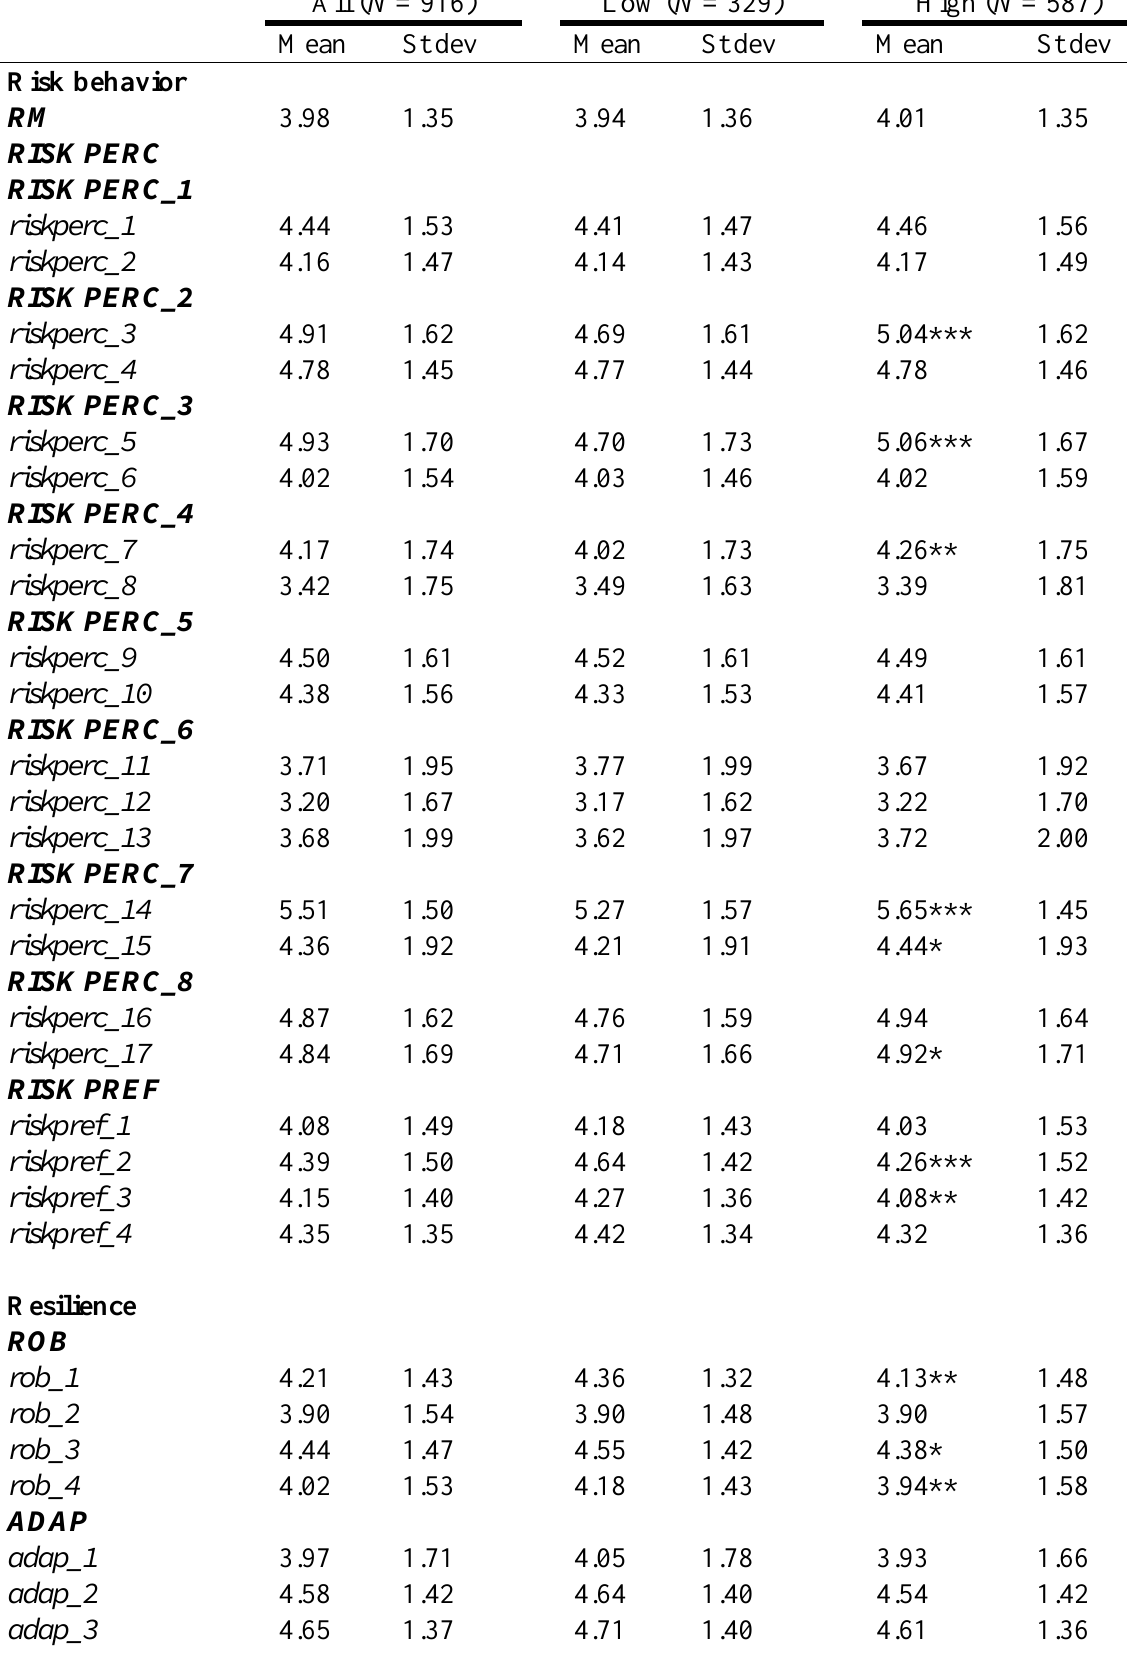
Table A1.11 . Summary statistics all farmers, Low , and High . All ( N = 916) Low ( N = 329) High ( N = 587) Mean St dev Mean St dev Mean St